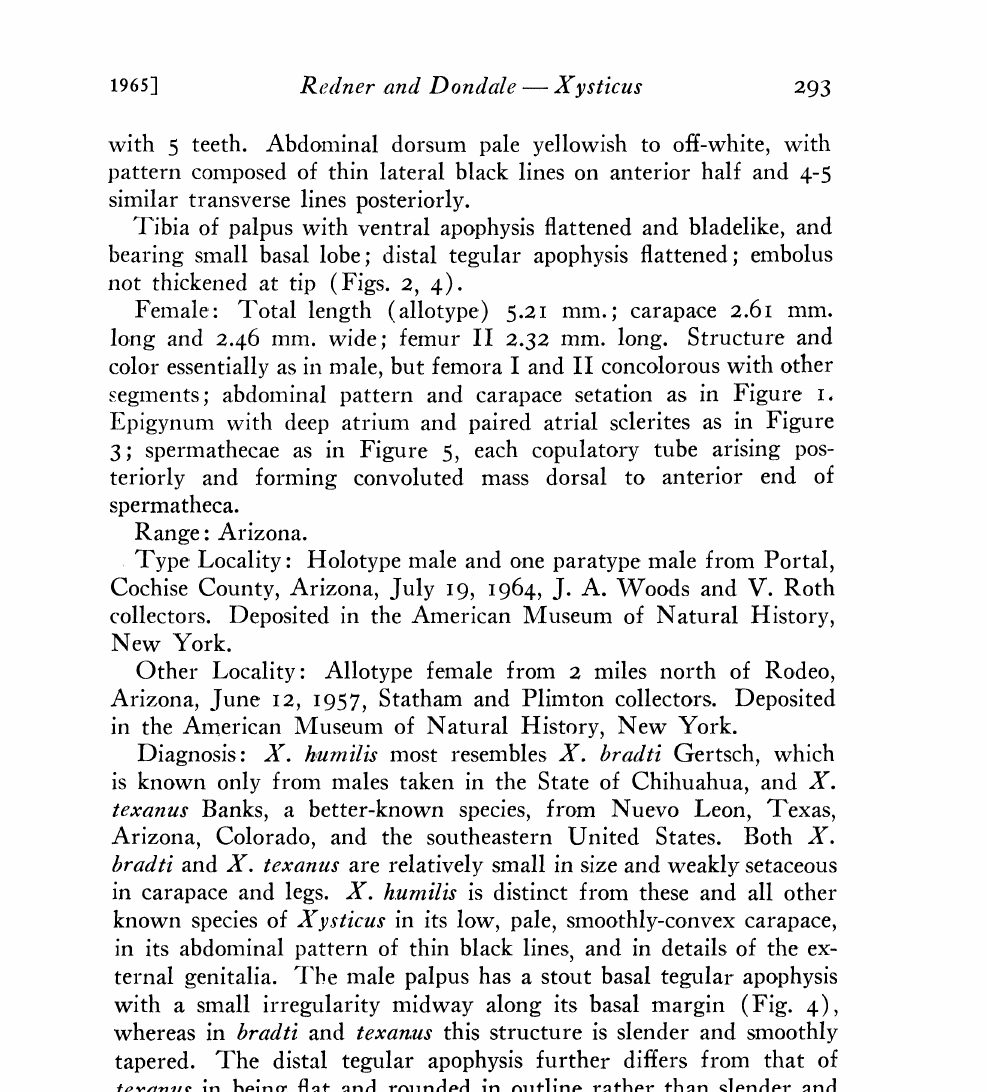
Figs. 1-5. Xysticus humilis sp. n. 1. Dorsal view of female. 2, 4. Male palpi. 3, 5. Female cpigynum and